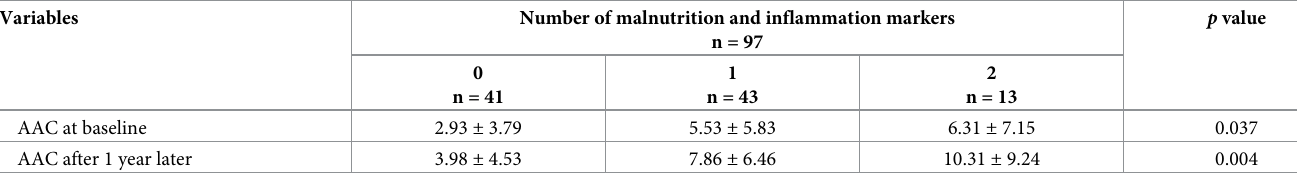
Table 3. AAC score after 1 year later according to the number of malnutrition and inflammation markers.